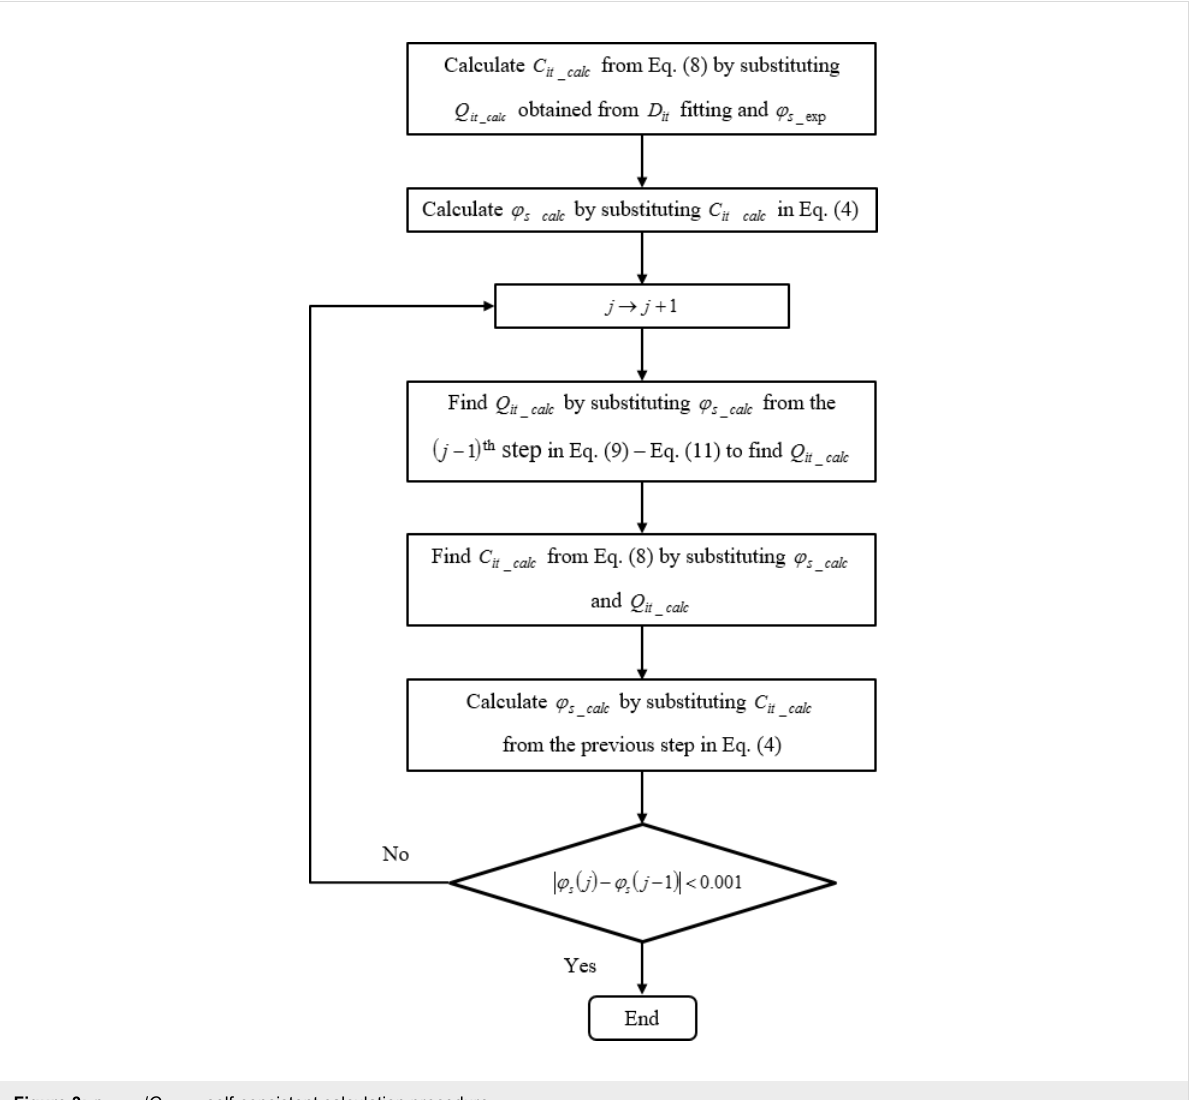
Figure 3: φ s_calc / Q it_calc self-consistent calculation